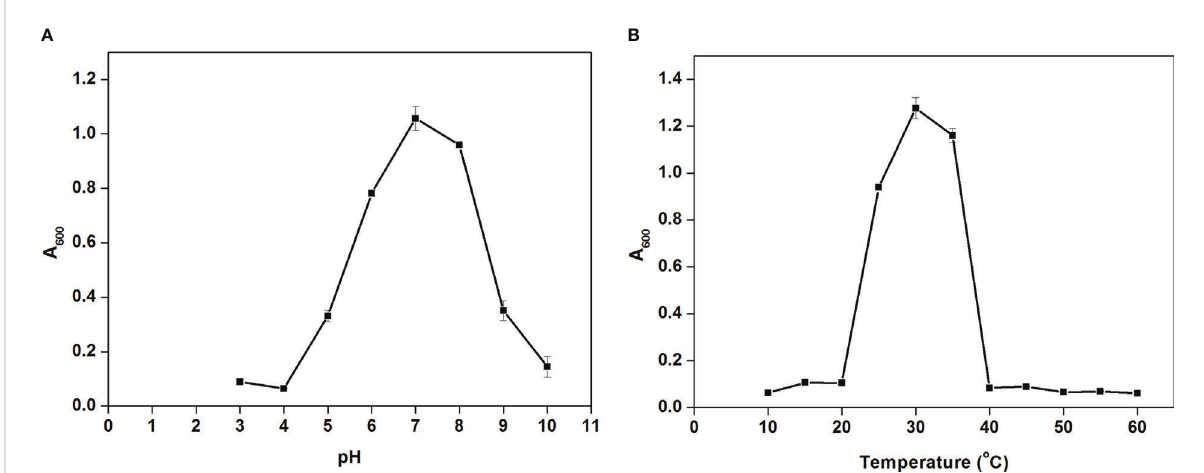
FIGURE 5 Growth pattern assessment of the Cellulomonas sp. HM71in Luria-Bertani broth with diverse pH (3-10 with an interval of 1.0 pH) (A) and temperature (10-60°C with an interval of 5°) (B) conditions for 24hrs with constant shaking at 200 rpm. Each point in the graph represents the mean of readings observed in triplicate experiments.